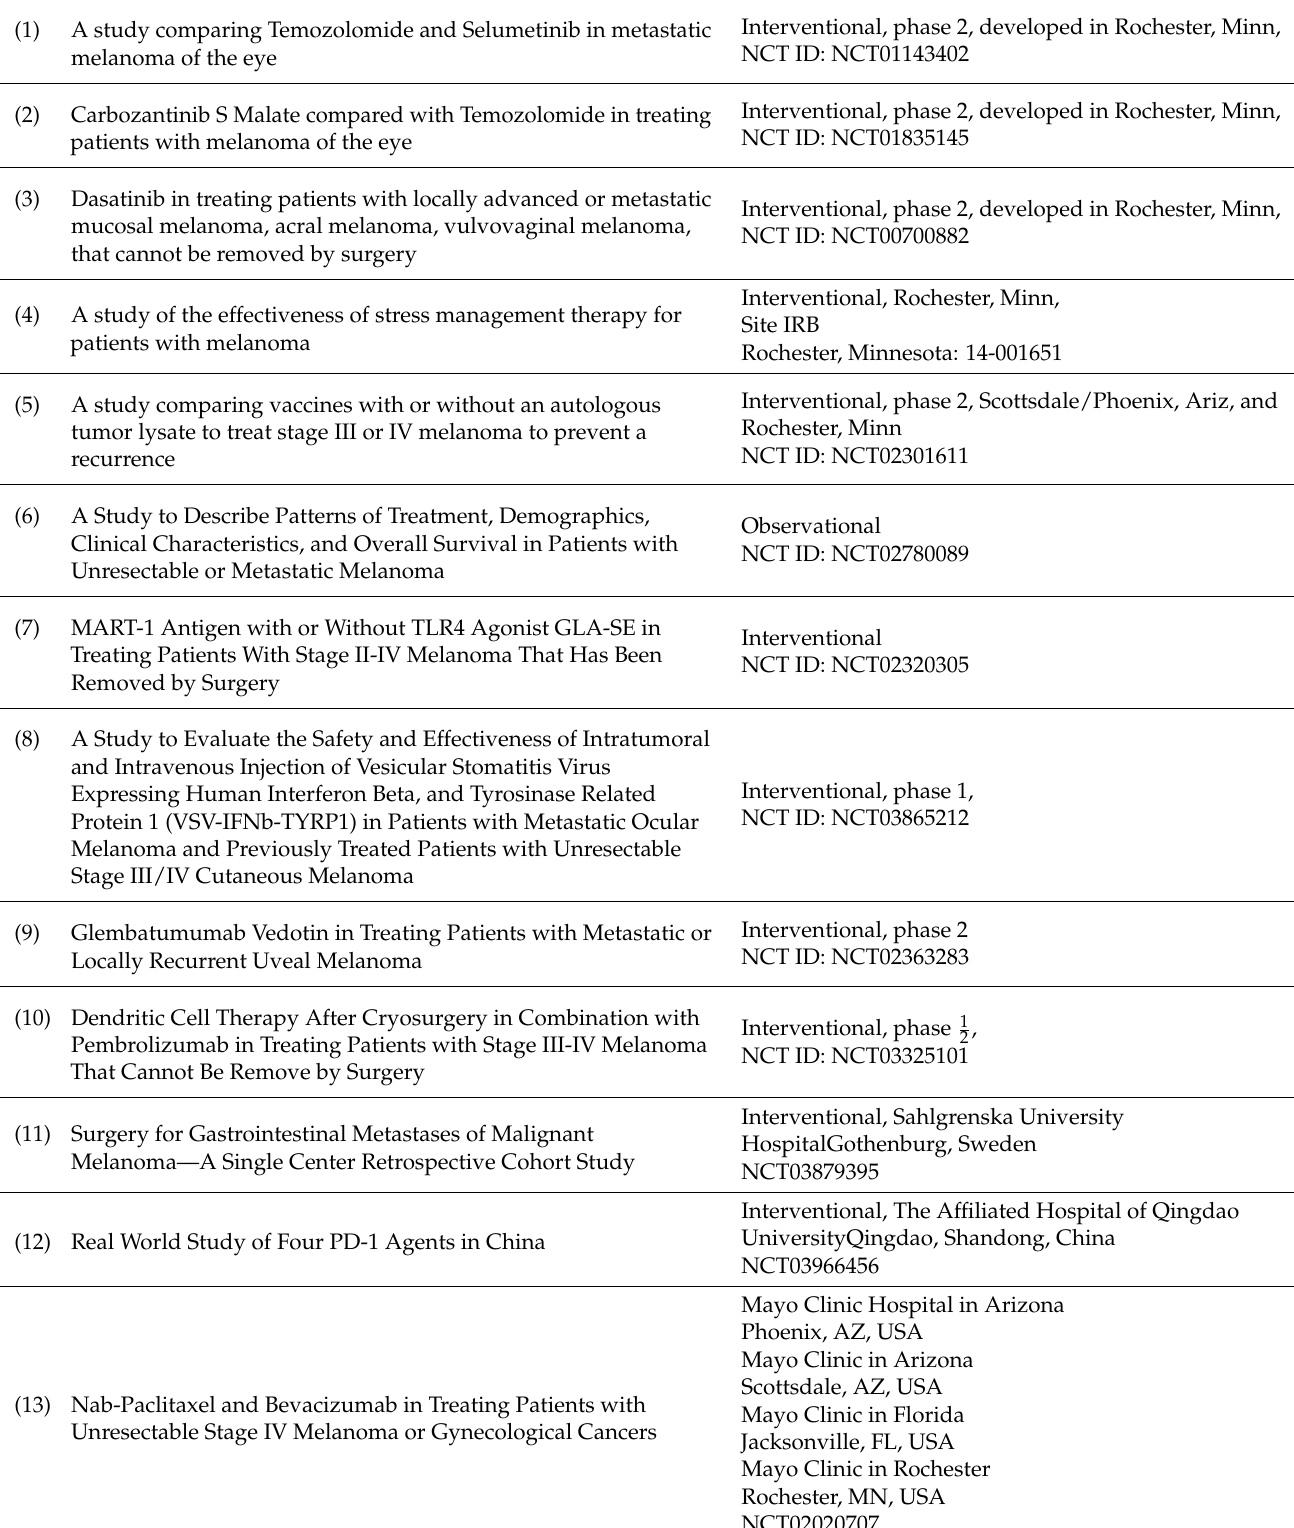
Table 4. Examples of current clinical trials on melanoma. More information on current trials